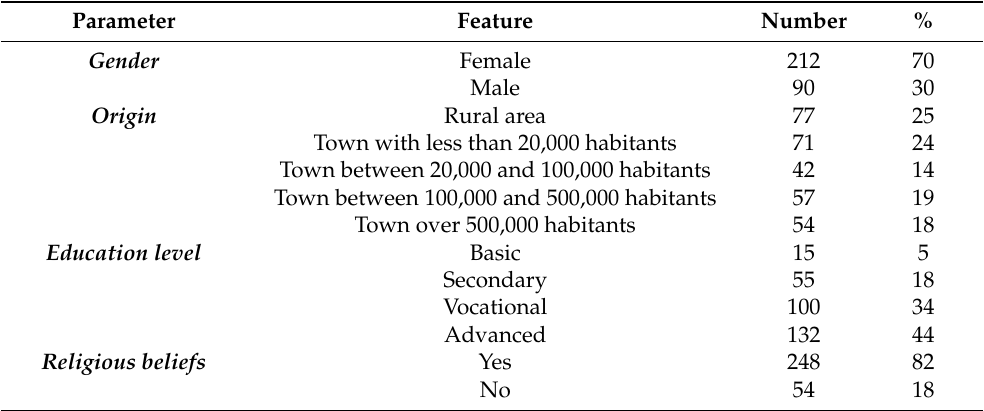
Table 1. Characteristics of the population